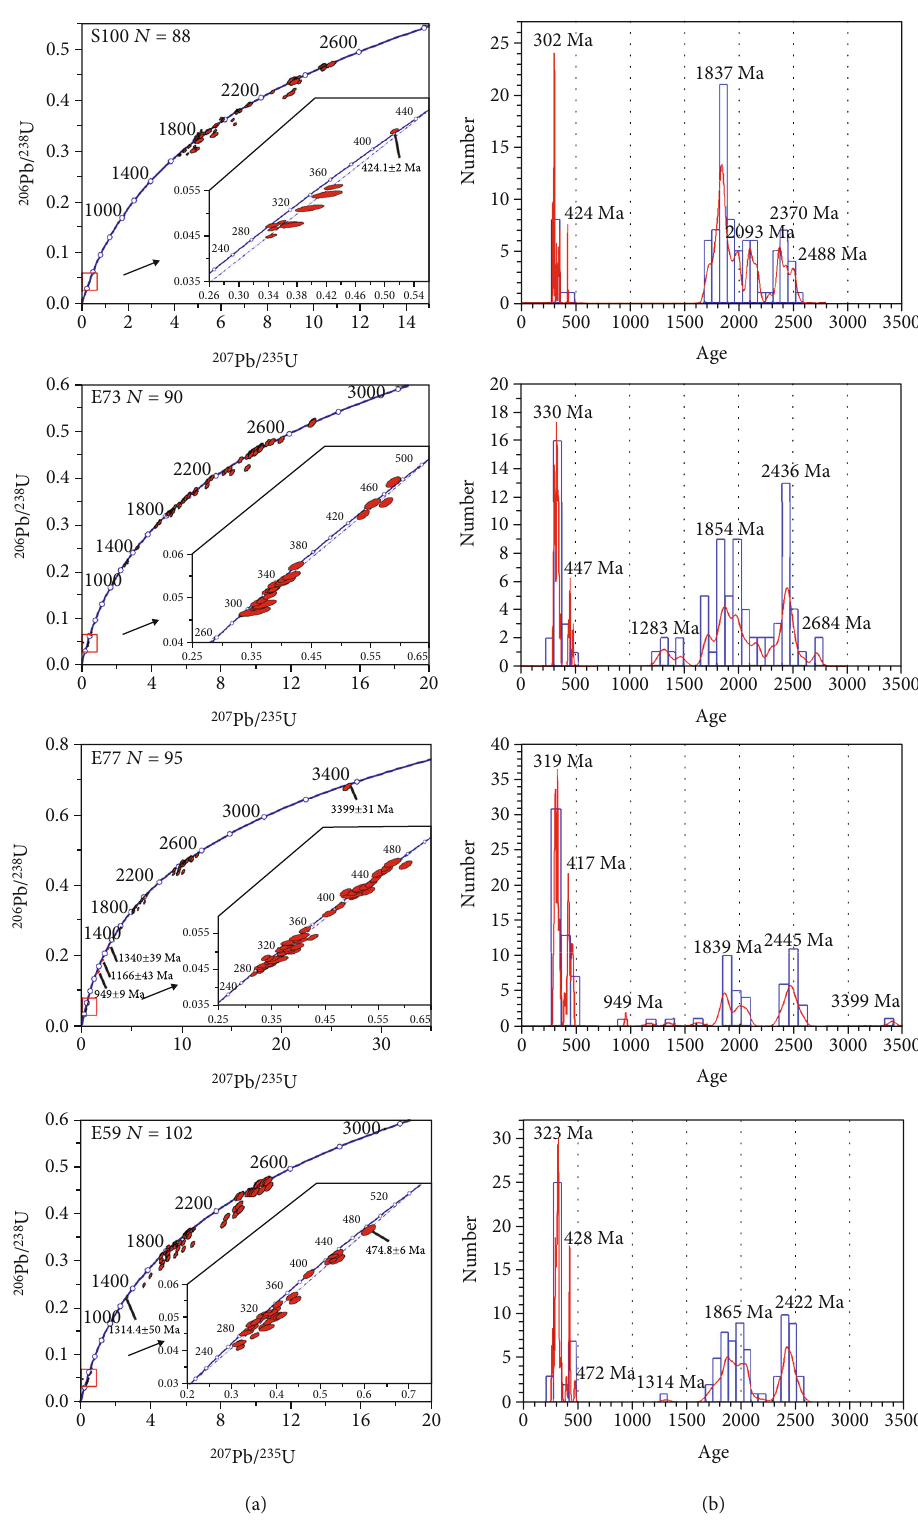
Figure 3: (a) shows the U – Pb concordia plots of concordant detrital zircons from the Shanxi Formation in the Otuokeqi area. (b) shows the detrital zircon U – Pb age (Ma) spectra including probability density curve and